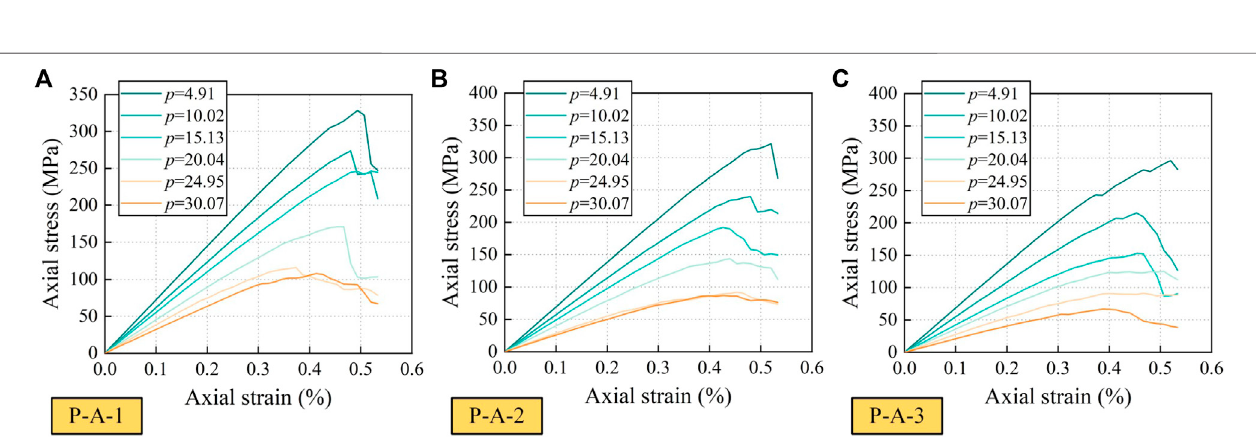
FIGURE 8 | Uniaxial stress-strain curves of groups (A) P-A-1; (B) P-A-2; and (C) P-A-3.